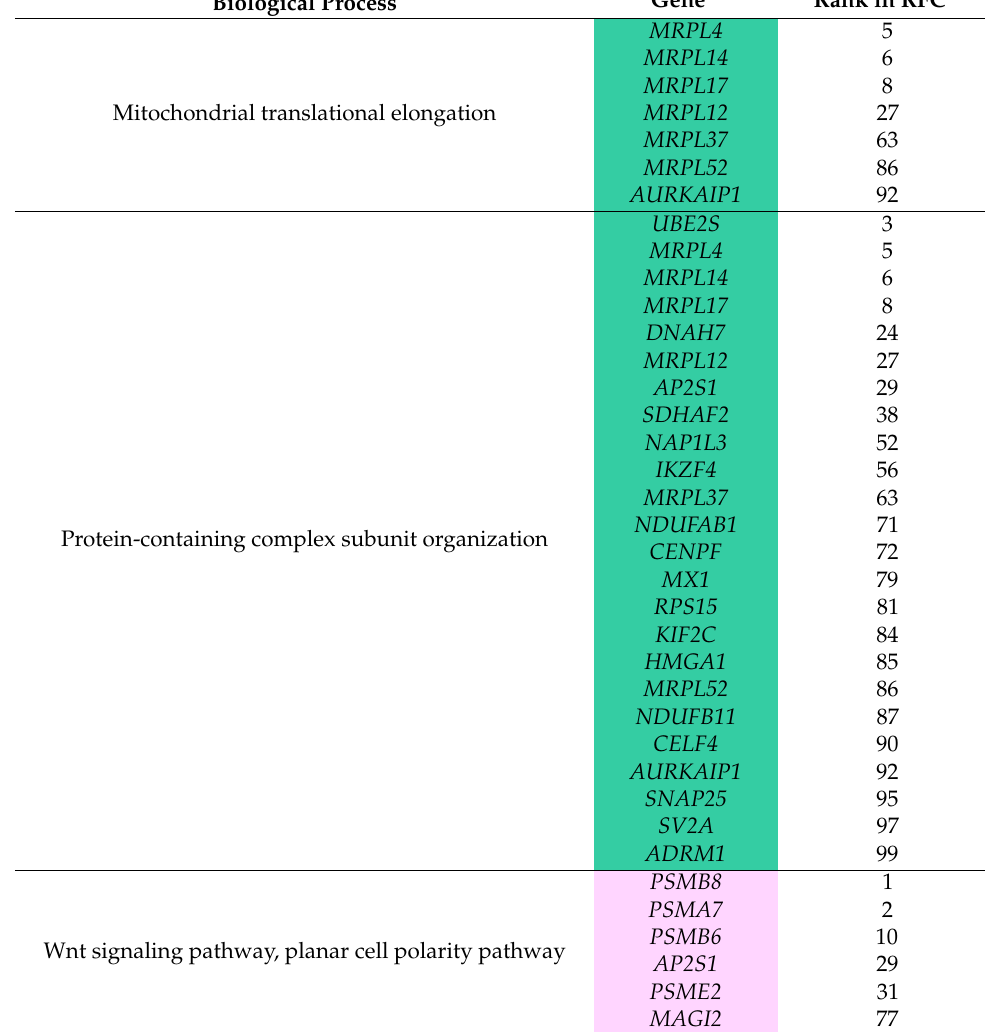
Table 3. Gene components for enriched biological